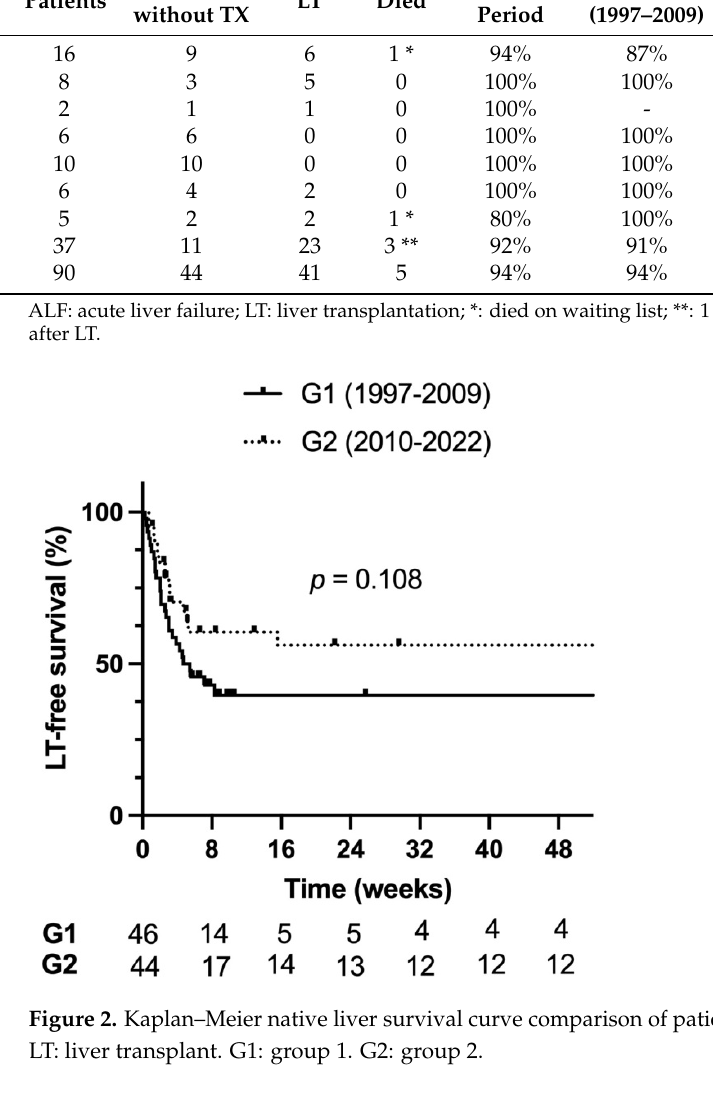
Figure 3. Comparison of the outcomes of patients with ALF according to era. LToD: liver transplant or death on waiting list. NLS: native liver survival; G1: group 1. G2: group 2. Figure 4. Comparison of the outcomes of patients with ALF according to era and aetiology. LToD: liver transplant or death on waiting list. NLS: native liver survival; G1: group 1. G2: group 2. AIH: autoimmune hepatitis; WD: Wilson disease; MP: mushroom poisoning; POD: paracetamol over- dose; IEMs: inborn errors of metabolism; ns: not signi fi cant.